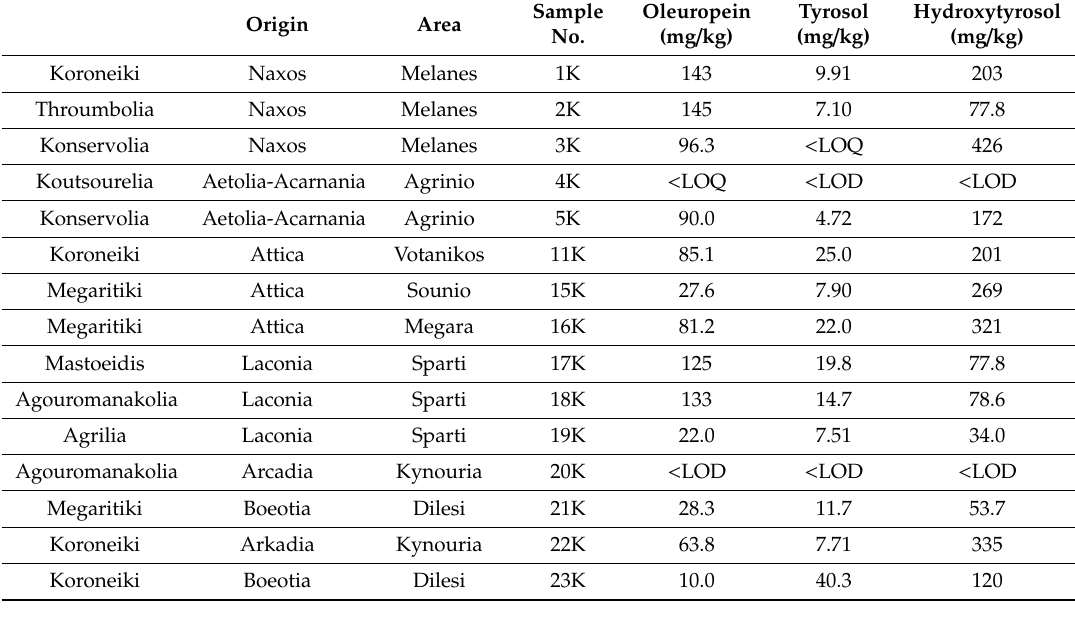
Table 7. Quantification results of oleuropein, tyrosol and hydroxytyrosol in drupes.